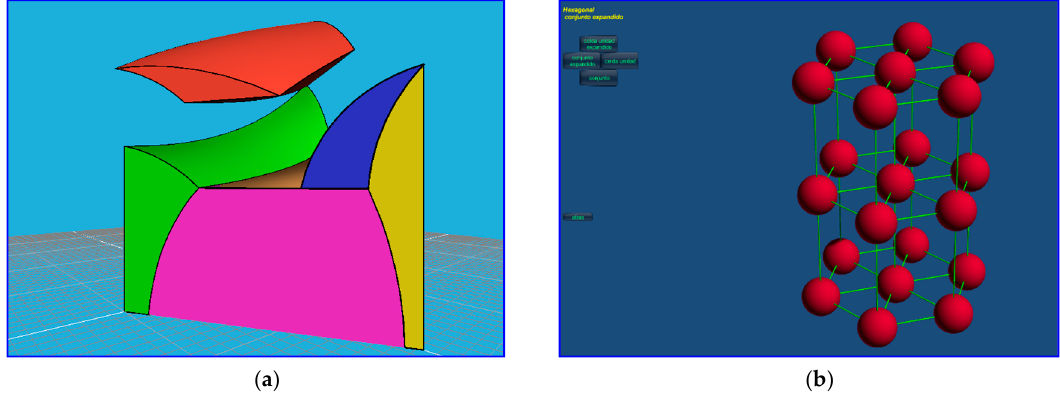
Figure 3. Illustration of previously developed VRLEs-1: ( a ) VRLE-1 system dedicated to TPD calculations and ( b ) VRLE-1 system focused on CL approximations.